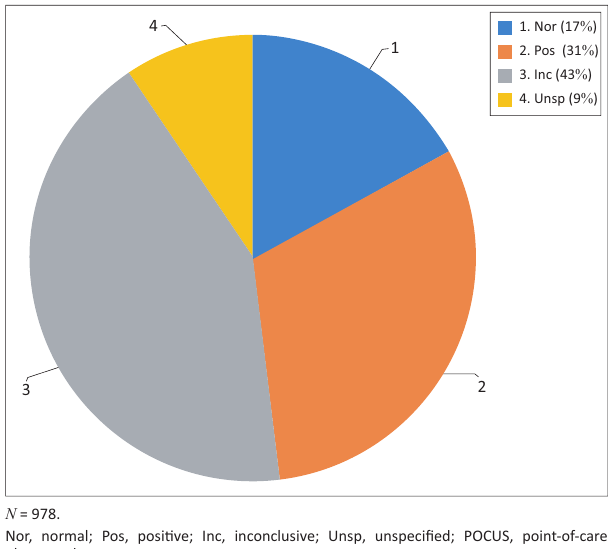
FIGURE 2: Total number of point-of-care ultrasounds performed and percentage contribution of the point-of-care ultrasounds findings.